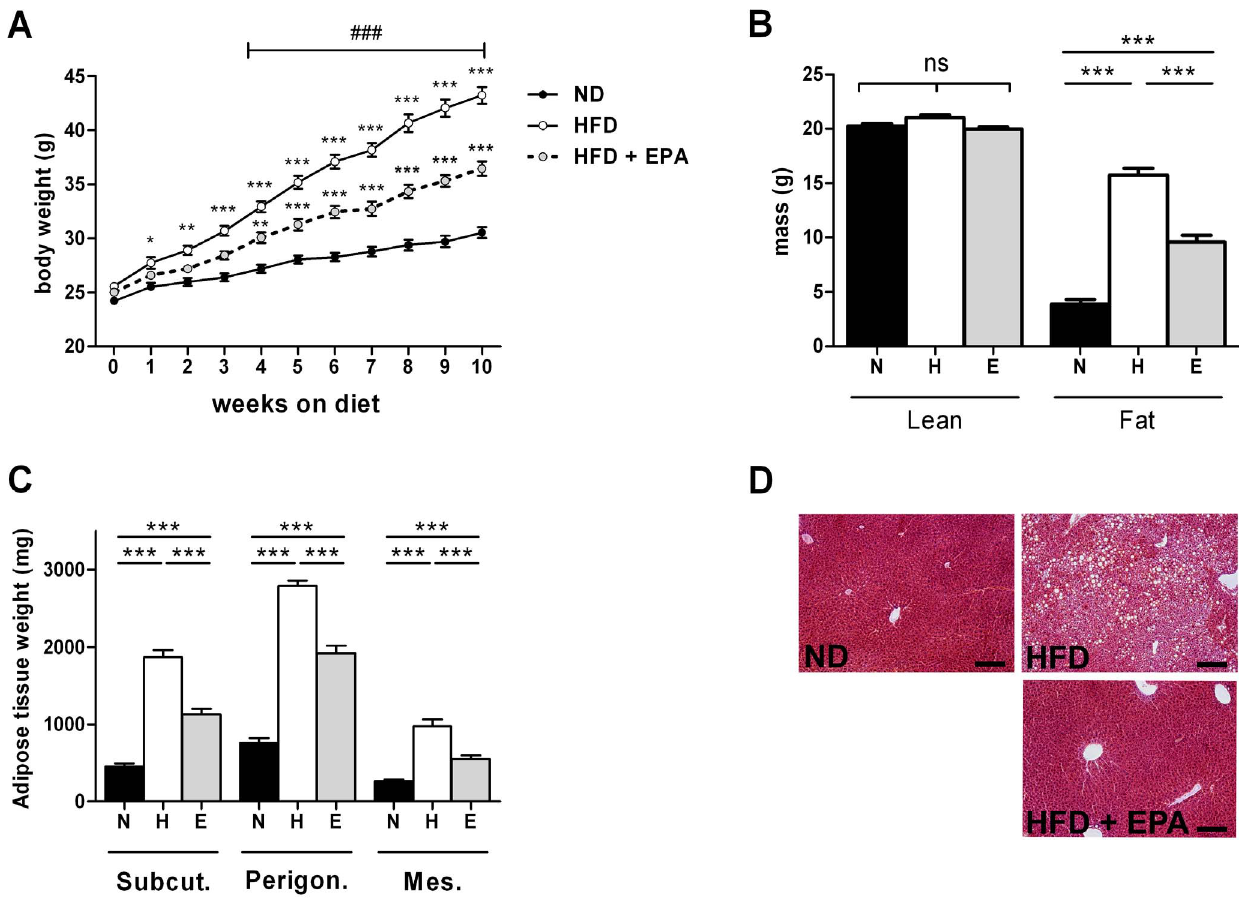
Figure 2. Protective effect of EPA supplementation on the HFD-induced obesity. (A) Body weight in mice after 10-week feeding with a ND (n=12), HFD (n=14) or HFD + EPA(n=14). Results represent mean 6 SEM. *p , 0.05, **p , 0.01, ***p , 0.001 vs ND; and ### p , 0.001 vs HFD, ns: not significant. (B) fat and lean mass and (C) fat pads weights of subcutaneous (Subcut), perigonadal (Perigon) and mesenteric (Mes) adipose tissue in mice fed for 10 weeks with a ND or N (n=12), HFD or H (n=14) or HFD + EPA or E (n=14) Results represent mean 6 SEM. ***p , 0.001, (D) Representative photographs of H&E staining of liver section of mice fed the different diets for 10 weeks (bar=200 m m).